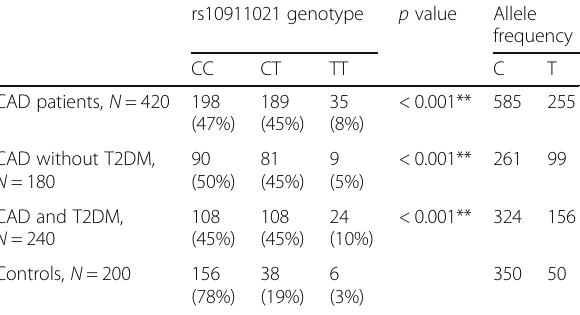
Table 2 Genotypes and allele frequency of GLUL